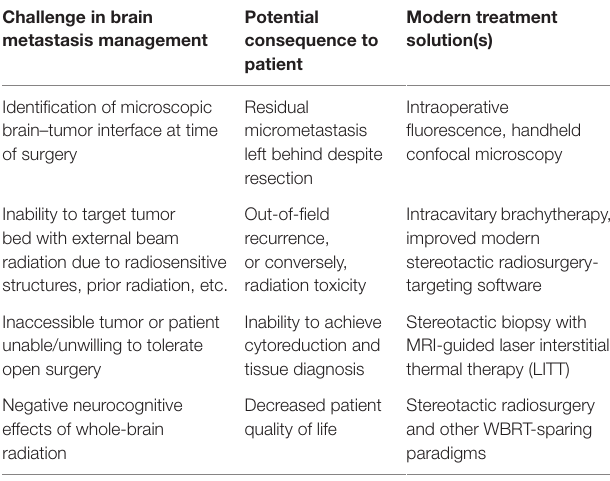
TABLe 1 | Modern challenges in the multimodality management of brain metastasis. Challenge in brain metastasis